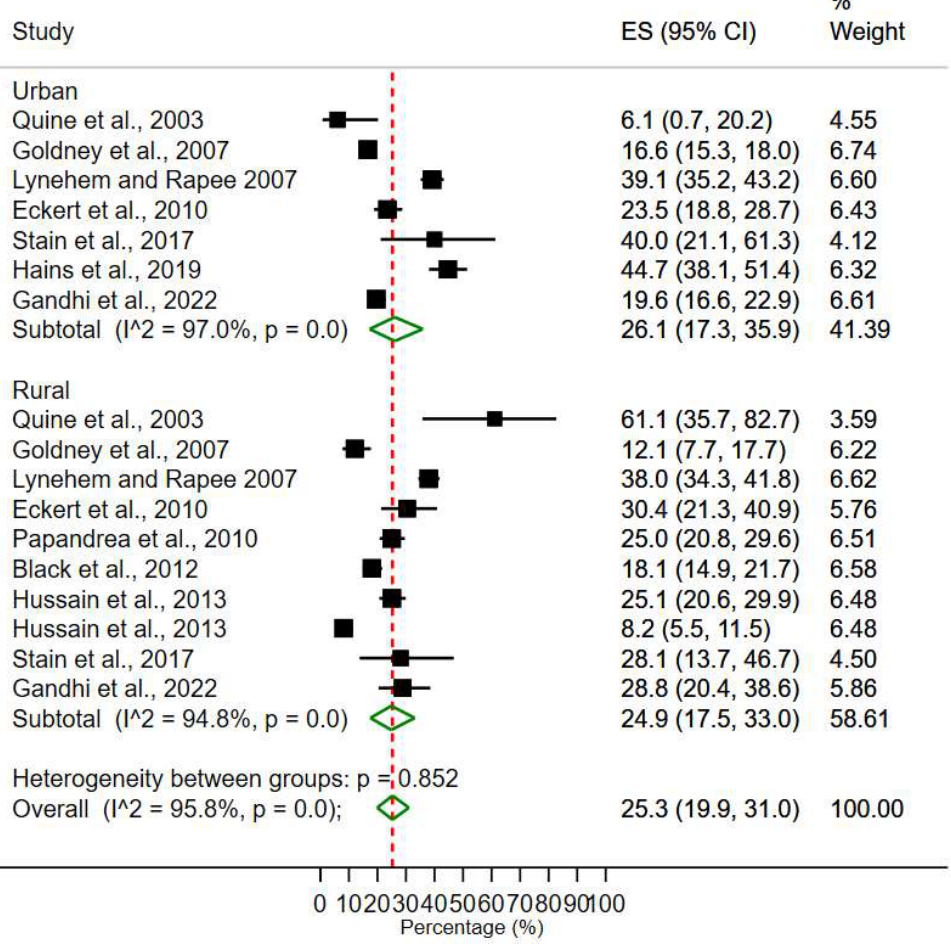
Figure 3. Meta-analysis and pooled estimate of urban area and rural areas [28,45,59–66].